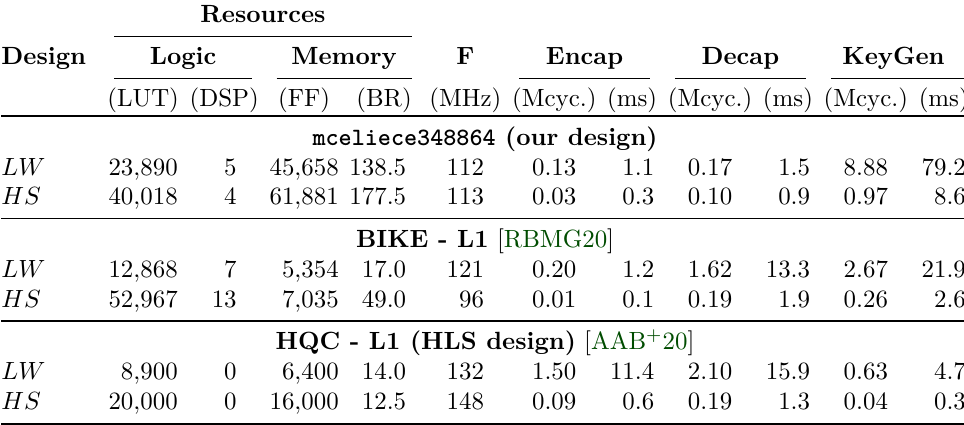
Table 11: Comparison of the time and area for our joint hardware design of Classic McEliece with other code-based schemes (as there is no other complete hardware implementation